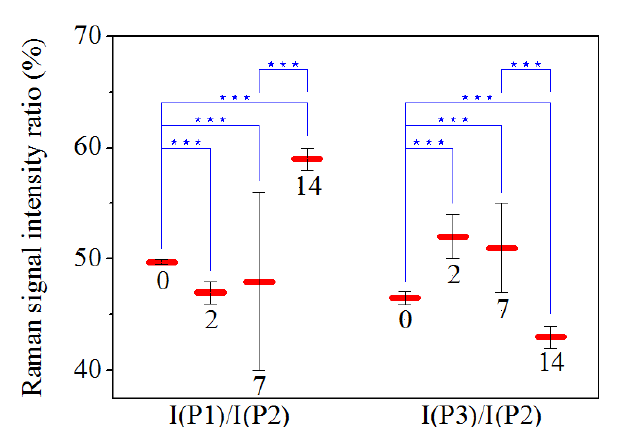
Figure 8. Comparison of mean values of Raman signal intensity ratios from control samples (0) and samples after 2, 7, and 14 days of OTM. The numerical values are expressed as the mean ± SD. The asterisks indicate that a significant difference between ratios occurred at * p ≤ 0.05; ** p ≤ 0.01; *** p ≤